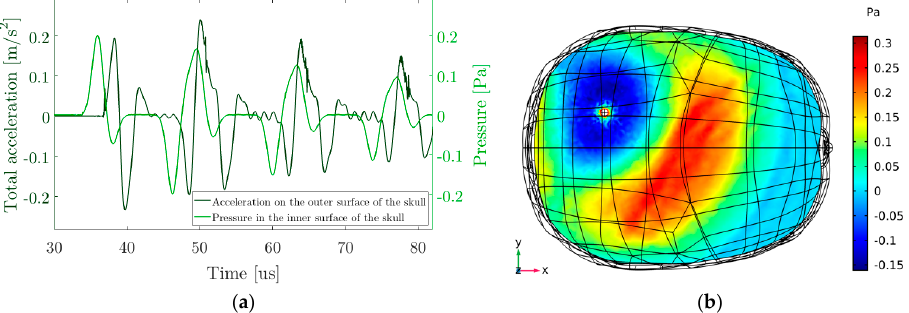
Figure 7 . ( a ) Signal received on one of the sensors and pressure on the surface of the skull; ( b ) Propagation in a plane in the X, Y plane 53 μ s after the energy deposition.